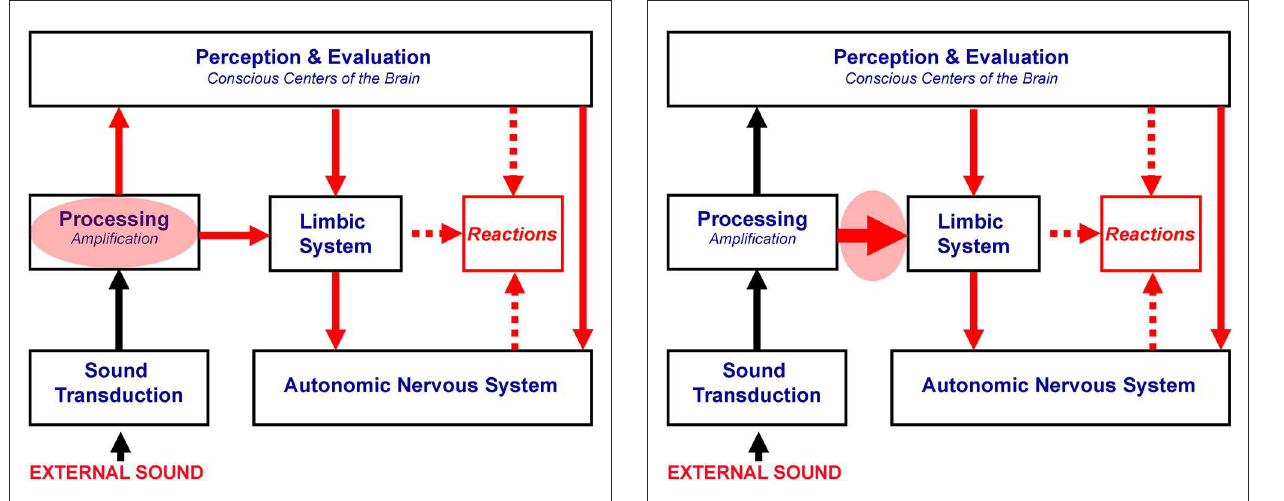
FIGURE1 Proposed mechanisms of hyperacusis. The red oval marks subconscious centers of the auditory pathway with increased gain, resulting in the over-amplification of neuronal activity evoked by bothersome sounds. This over-amplification is postulated to be responsible for hyperacusis. Red arrows show the spread of the enhanced neuronal activity, yielding the overactivation of the limbic and autonomic nervous systems, which are dominant in the generation of negative reactions.